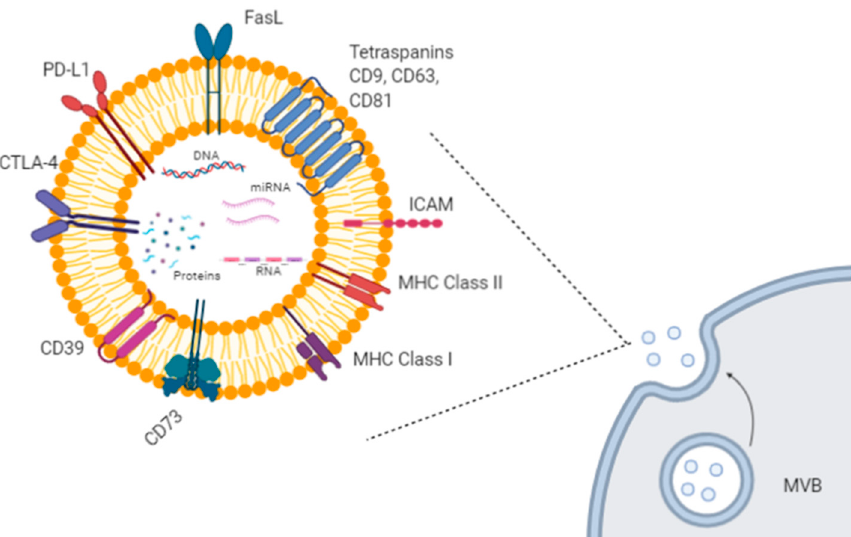
Figure 1. Exosome biogenesis and molecular cargo. Exosomes are extracellular lipid vesicles (EVs) produced within the endosomal compartment called multivesicular bodies (MVB). Exosomes’ cargo includes proteins, DNA, mRNAs, and miRNAs. Some proteins represent exosome markers (e.g., tetraspanins CD63, CD9, CD81), while other proteins are variable depending on the cell type origin, including adhesion molecules (ICAM and integrins), immune-suppressive proteins (CTLA-4, PD-L1, Fas-L, CD39, CD73), major histocompatibility (MHC) molecules, enzymes, and growth factors. Created with BioRender.com.